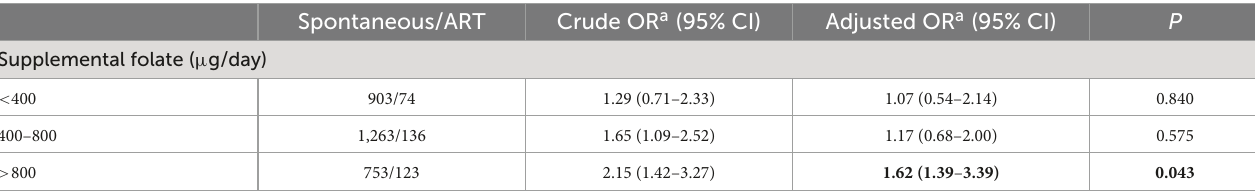
TABLE 4 Association of ART with maternal gestational diabetes mellitus, stratified by supplemental folate. Spontaneous/ART Crude OR a (95% CI)